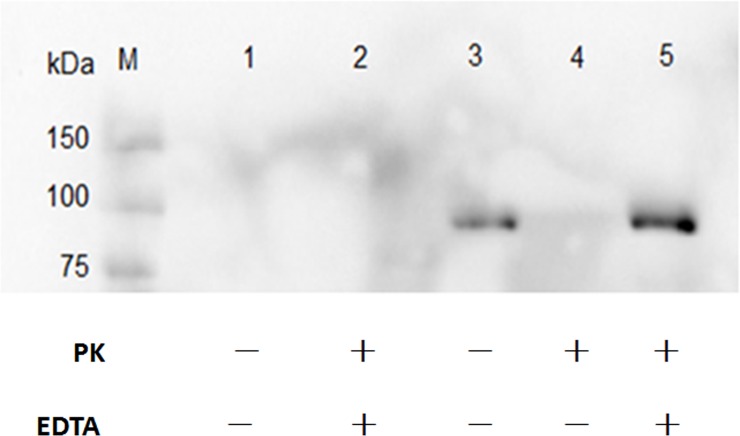
Demonstrate the distribution of ClyA-Apxr in Apxr-OMVs.Lane M: protein marker. Lane 1: the OMVs-empty. Lane 2: proteinase K plus EDTA treated Apxr-OMVs. Lane 3: untreated Apxr-OMVs. Lane 4: proteinase K treated Apxr-OMVs. Lane 5: EDTA treated Apxr-OMVs.